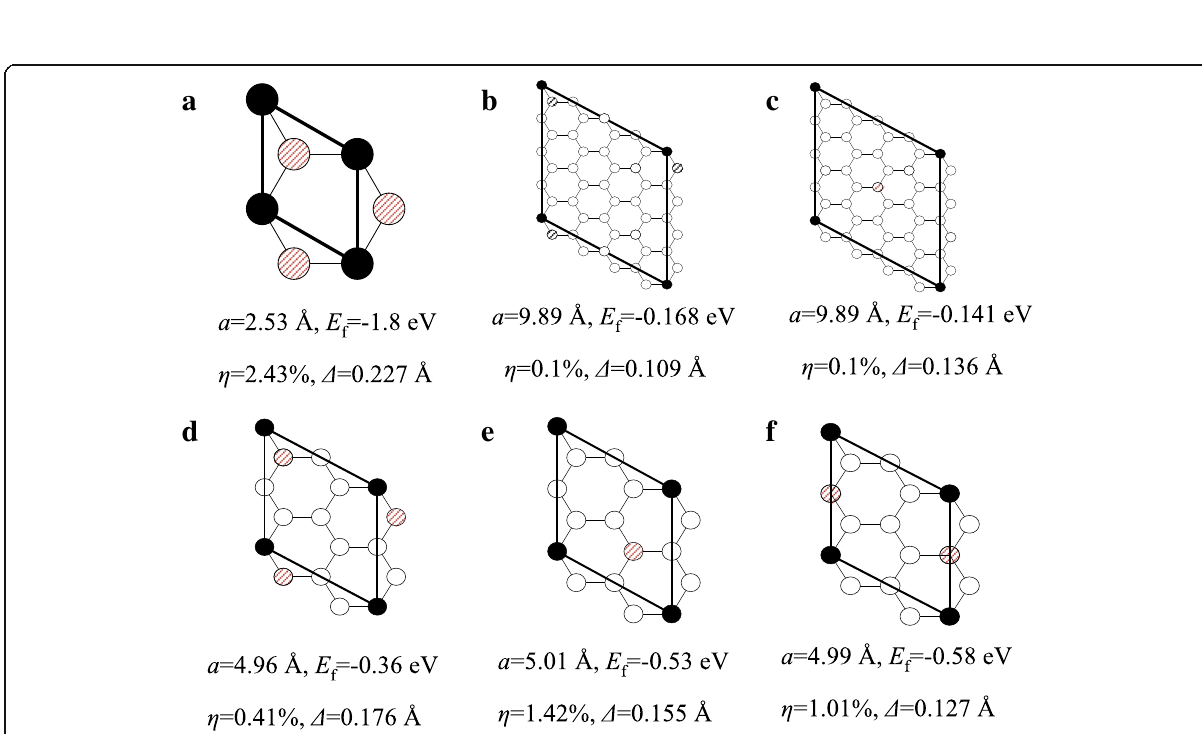
Fig. 3 Schematic of primitive cell of HGs with different hydrogen coverage and pattern. a 100%. b , c 6.25% patterns I and II. d , f 25% pattern I –